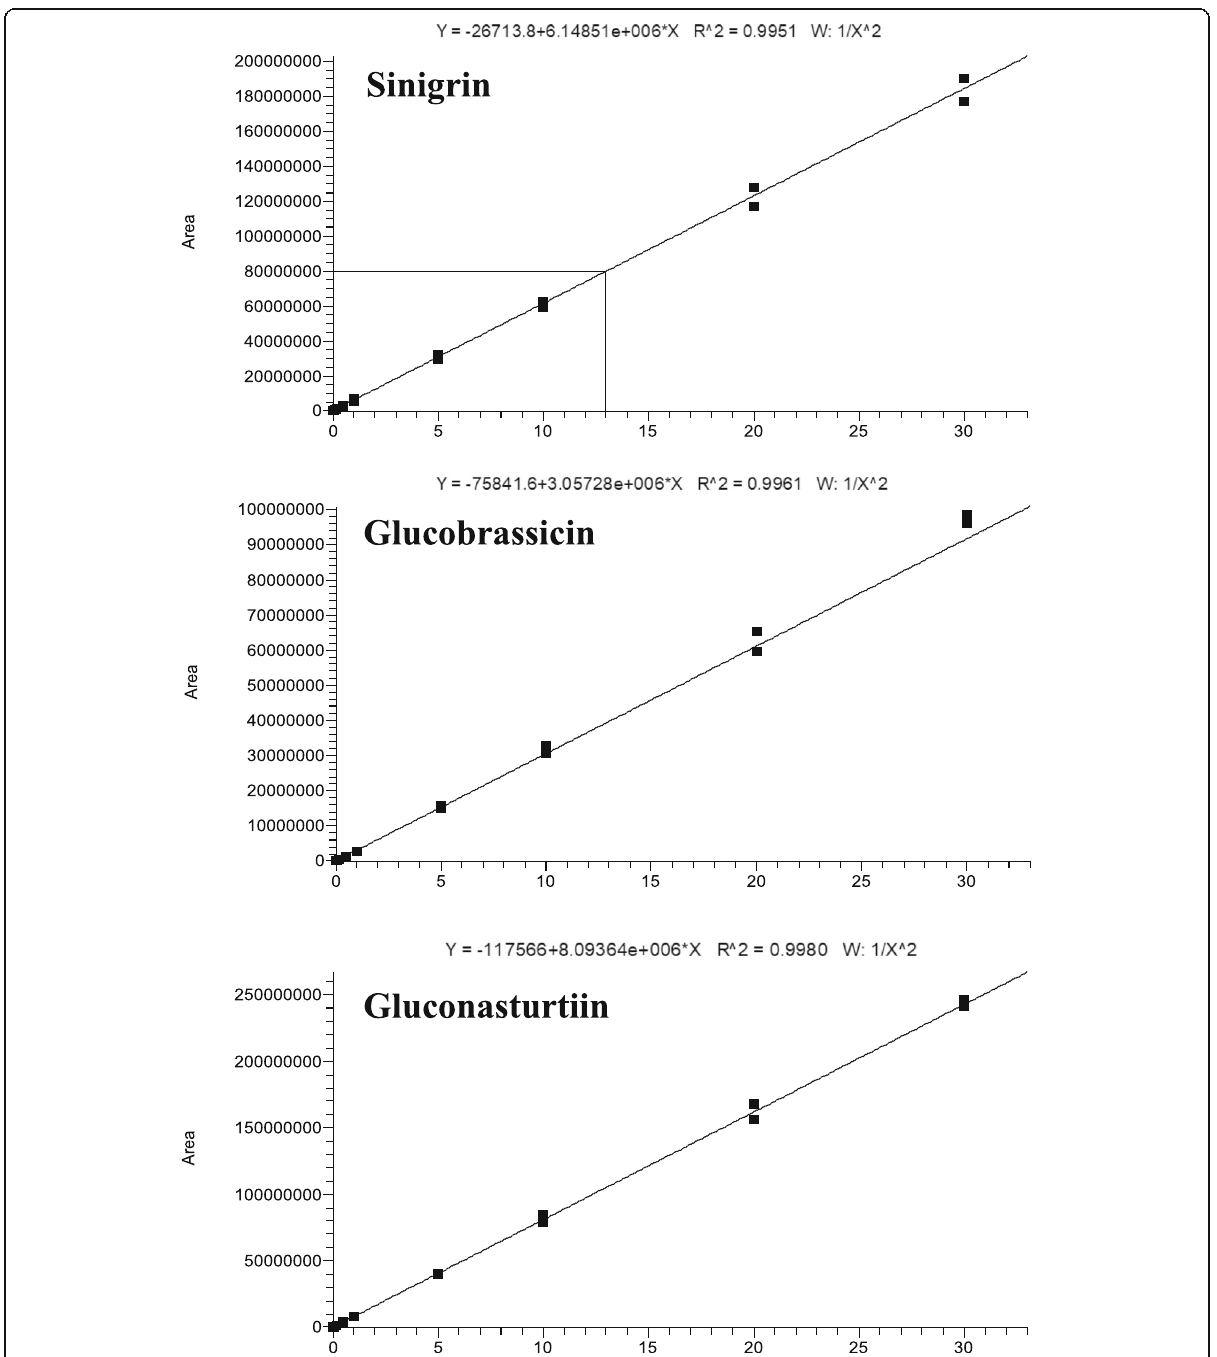
Fig. 3 Calibration curves (R 2 > 0.99) obtained by running a three-standard mixture of sinigrin, glucobrassicin and gluconasturtiin with the concentration range of 0.01 to 30 μ